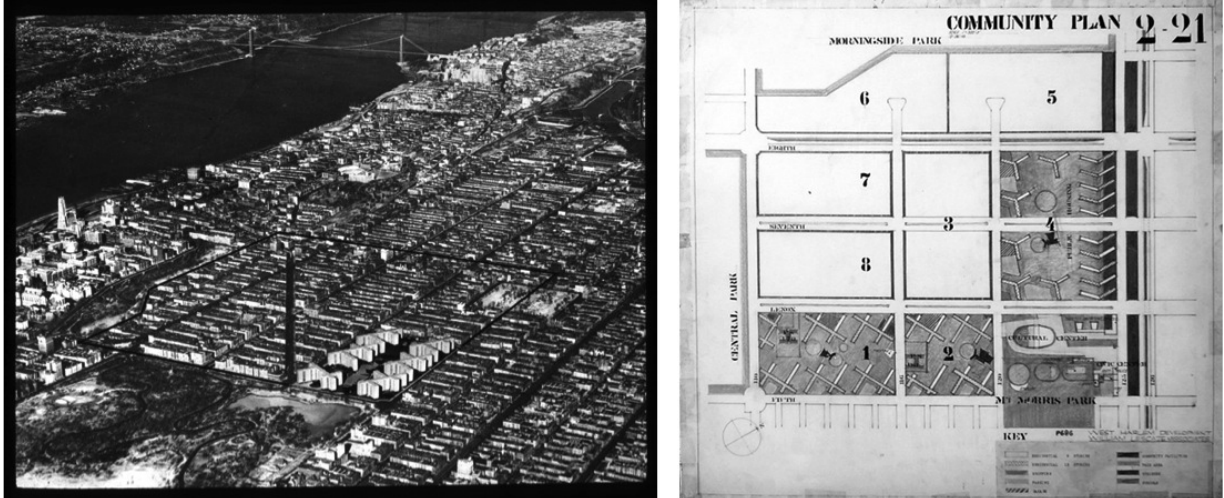
Figure 11. Aerial view of the West Harlem Housing Development by W. Lescaze & Associates (1942–1944; left) and site plan of the Dorie‐Miller Housing Project in West Harlem Housing Development by W. Lescaze and J. Felt (1942–1944; right). Sources: “Planned neighborhoods for 194X” (1944, pp. 148,